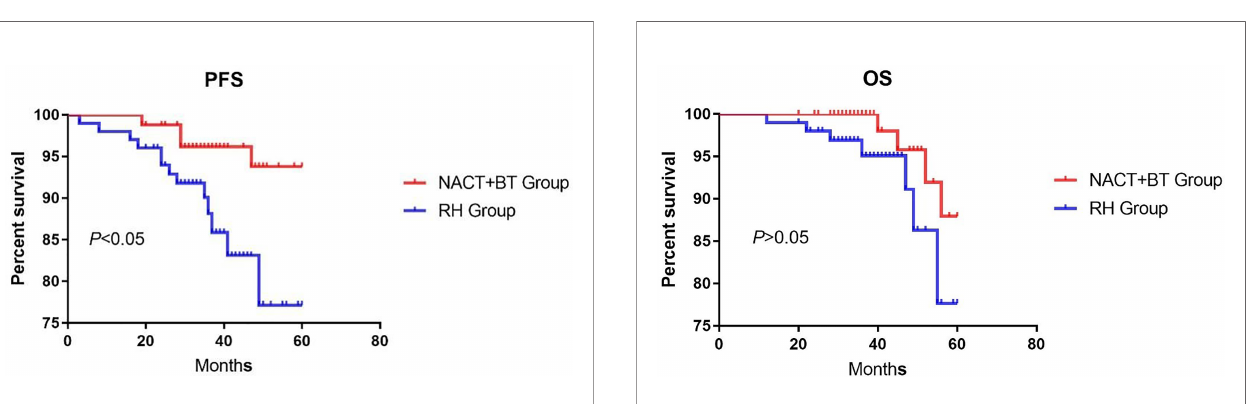
FIGURE 1 | Progression-free survival.